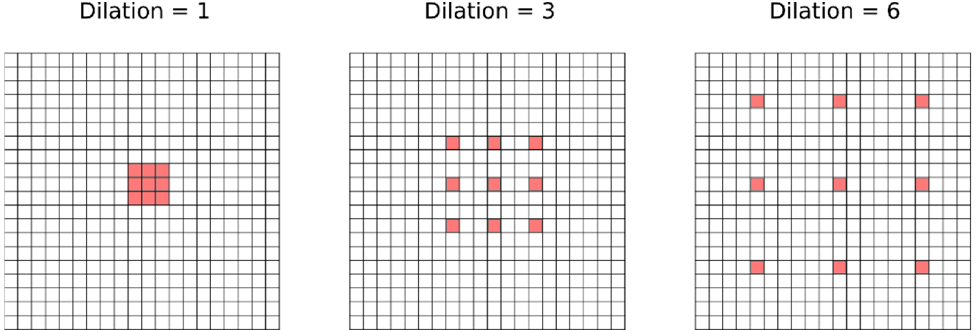
Figure 5. The residual block used in our architecture, it performs 2 convolutions and then the residual operation to avoid the degradation in the feature map generated.